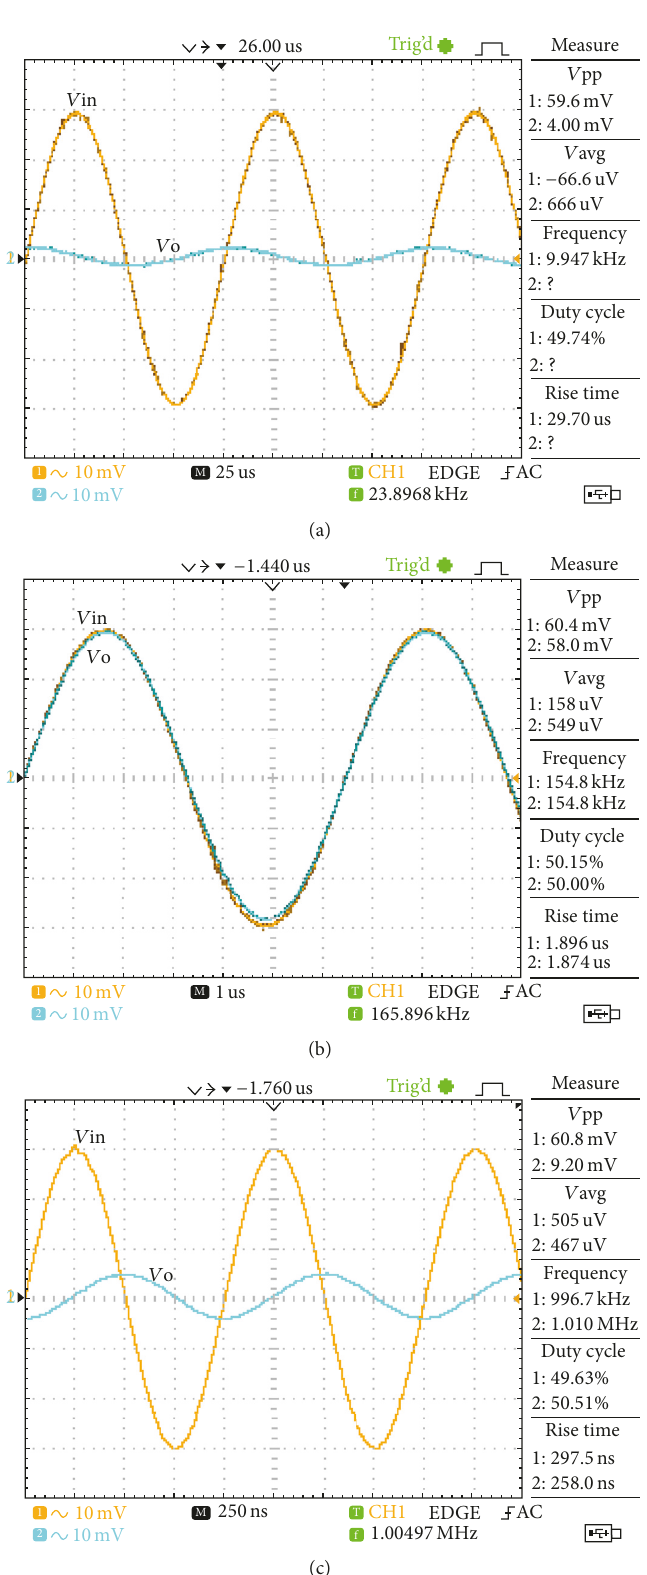
Figure 7: The measured input and output waveforms of band-pass filter at (a) 10kHz, (b) 155 kHz, and (c)